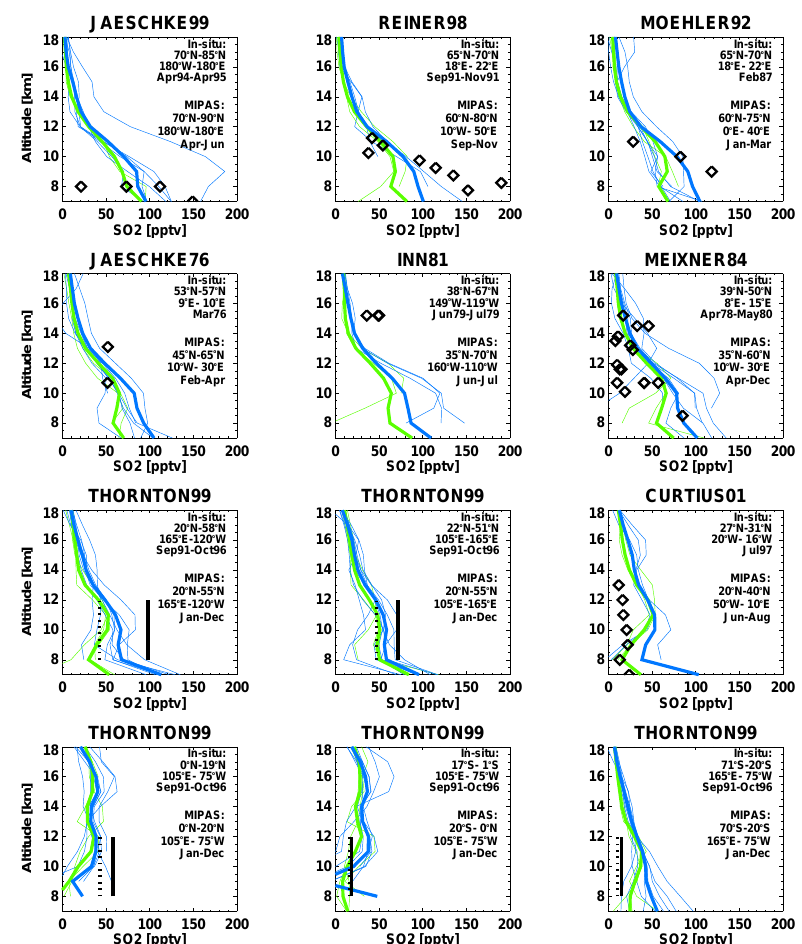
Figure 7. Comparison between in situ and debiased MIPAS observations of SO 2 . Green lines indicate MIPAS measurements before April 2004 and blue lines after January 2005 (solid thin lines: mean of each year, solid bold lines: mean of all profiles). Black diamonds show the in situ observations based on publications as given in the plot title (JAESCHKE76: Jaeschke et al. (1976), INN81: Inn and Vedder (1981), MEIXNER84: Meixner (1984), MOEHLER92: Möhler and Arnold (1992), THORNTON99: Thornton et al. (1999), CURTIUS01: Curtius et al. (2001), JAESCHKE99: Jaeschke et al. (1999), REINER98: Reiner et al. (1998). In the case of THORNTON99, the data from Thornton et al. (1999, Plate 3) have been subdivided into five regions over the Pacific (bold black lines: mean, dotted: median). Periods with strong volcanic influence have been excluded from the MIPAS data (see caption of Fig.